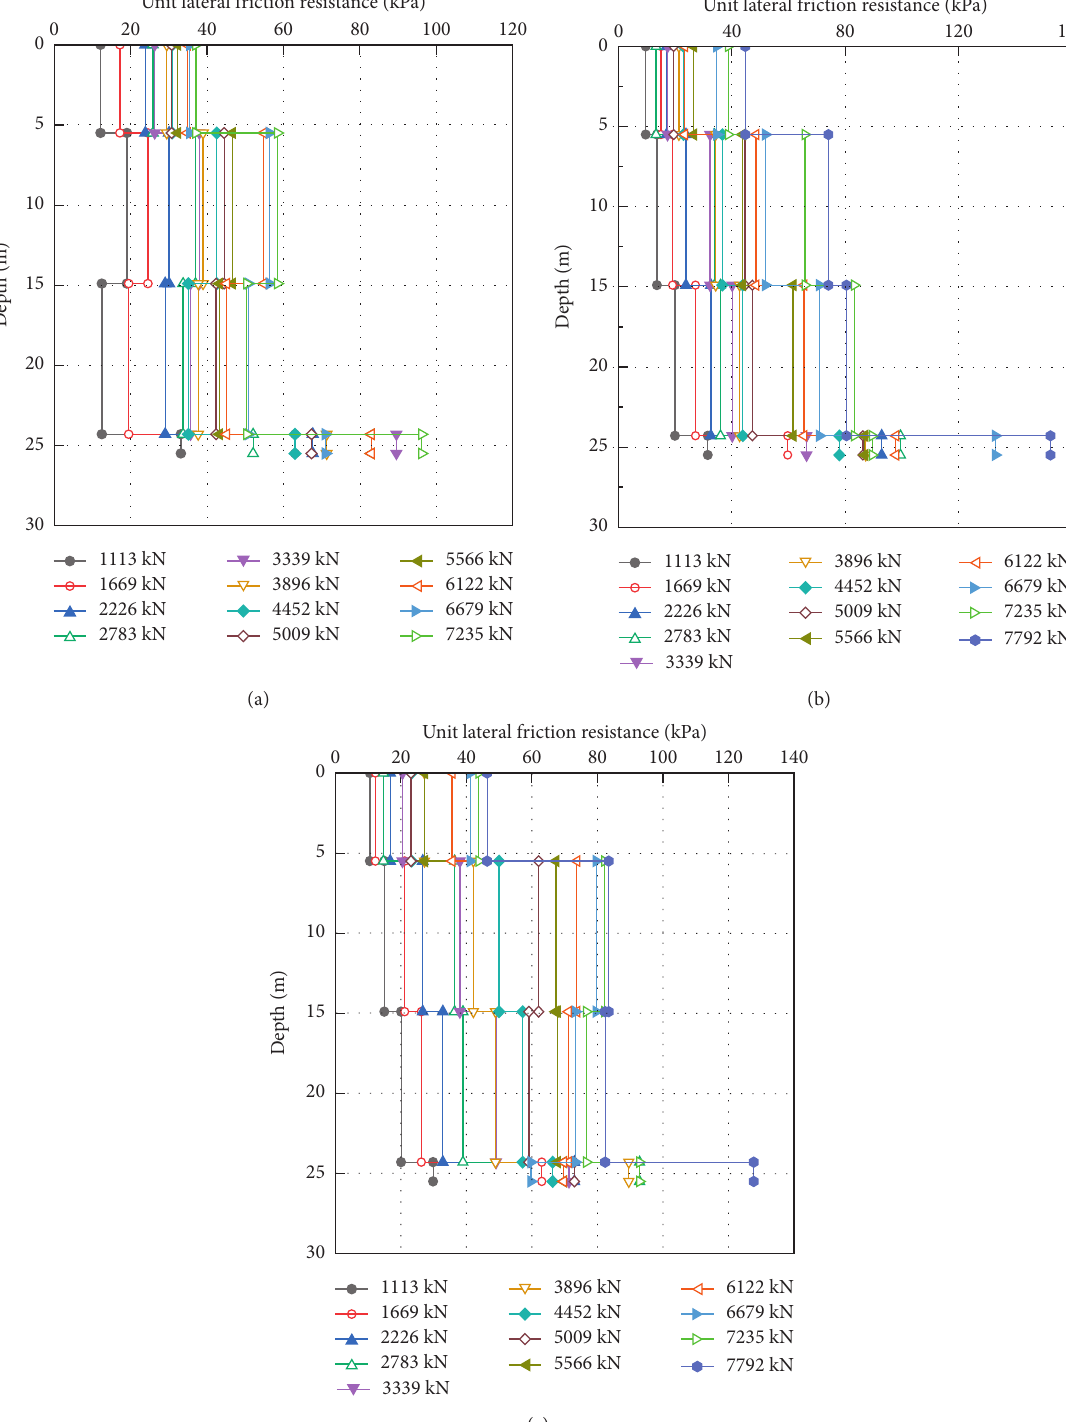
Figure 5: Distribution of side friction resistance: (a) TP1; (b) TP2; (c)